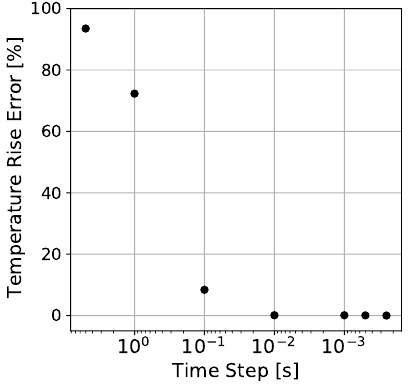
Figure 3. Reduction in temperature rise error between simulation and analytical results for decreasing time-step